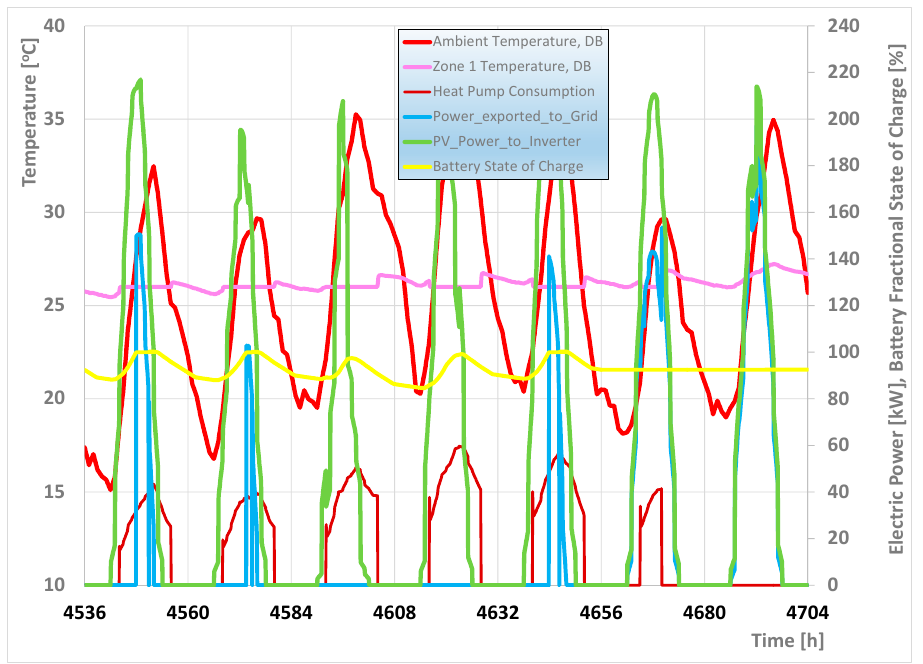
Figure 4. Transient operation of the system during the second week of July. Lowest threshold for aggregate ba tt eries’ SOC = 0.36. 20 kW Genset. Indoor temperature set point at 26 °C.